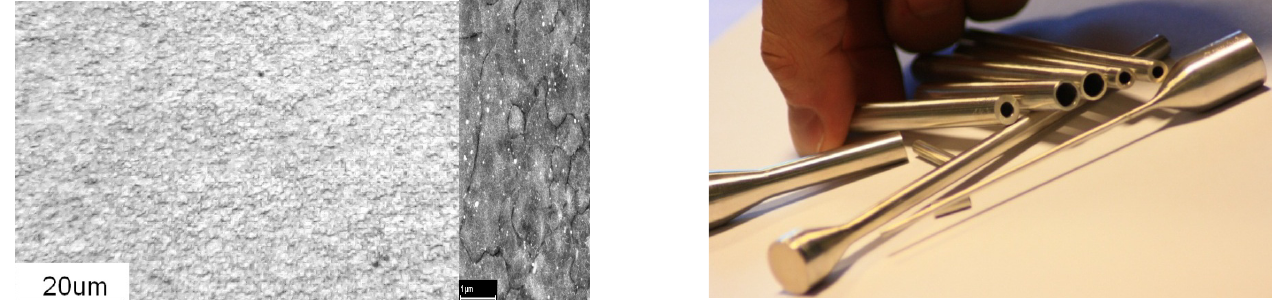
Figure 7: On the left: UFG of ZM21 alloy after ECAP; on the right: stent